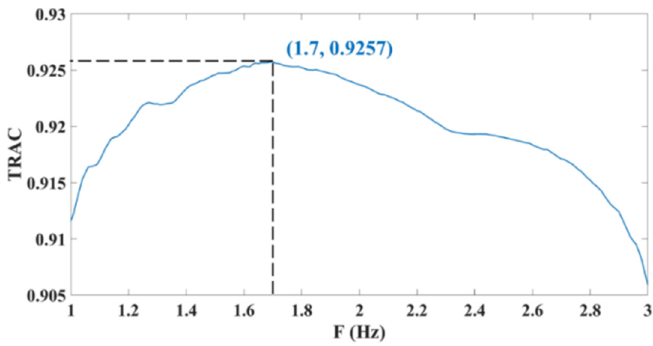
Figure 11. The relationship between 𝐹 and TRAC.